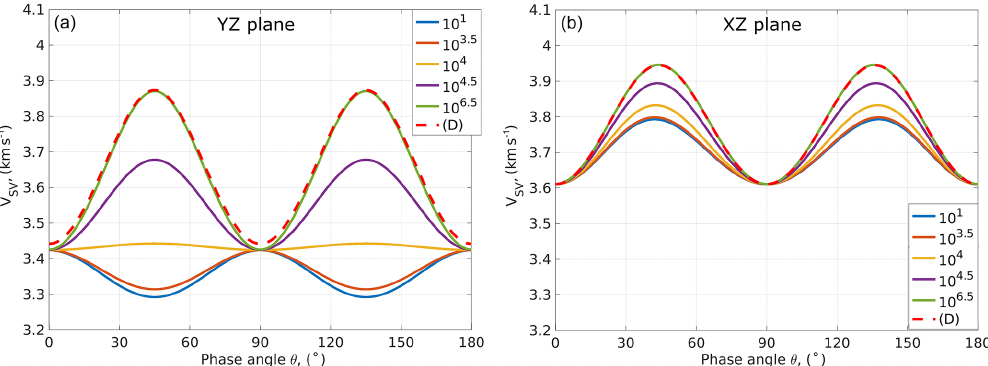
Figure 6. SV-wave phase velocity versus phase angle in the Y – Z plane (a) and the X – Z plane (b) . Curves 10 1 − 10 6 . 5 denote the frequency of the P wave for the model with connected cracks. (D) denotes the P wave for the model with disconnected cracks.